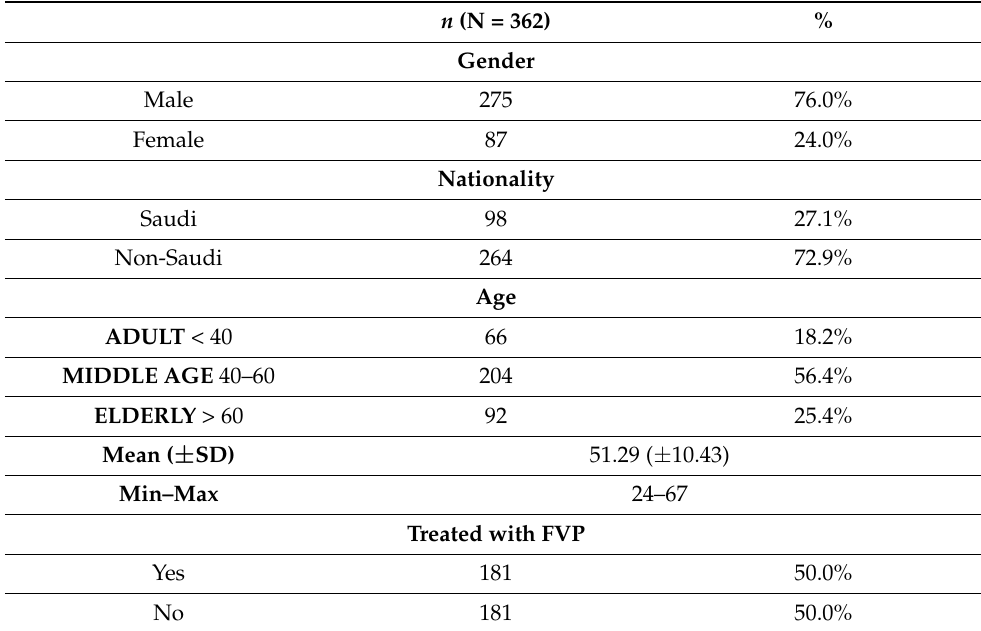
Table 1. Demographic data of the studied